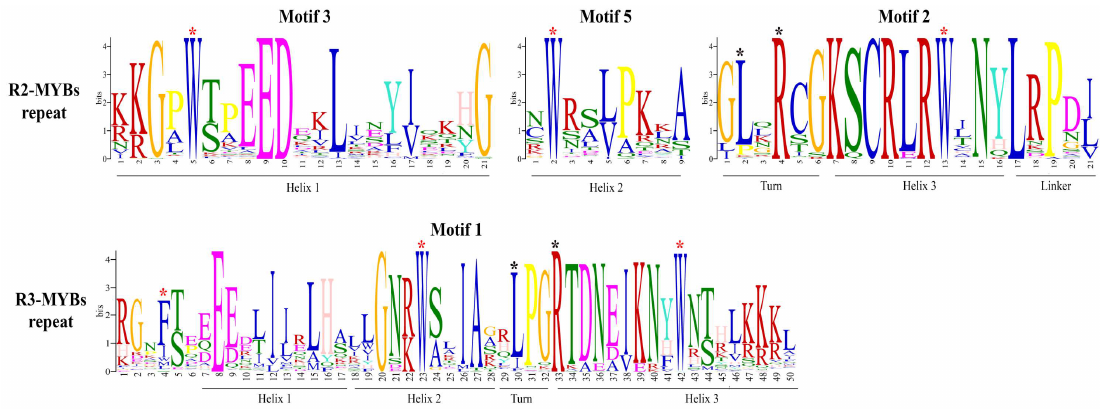
Figure 6. Logo consensus sequences of MYB subfamily from Cannabis. The logo sequences of motifs 3, 5, and 2 together constitute the R2 repeat; motif 1 corresponds to the R3 repeat of MYB domain. Red stars indicate conserved tryptophan residues, while black stars mark other conserved amino acid residues discussed in the text. The overall height of each stack indicates the conservation of the sequence at a certain position. The capital letters indicate > 50% conservation of amino acids within the domains. The motif width is indicated by Arabic number under the colored letters, where each color represents a type of amino acid. Full sequences are listed in Supplementary Dataset